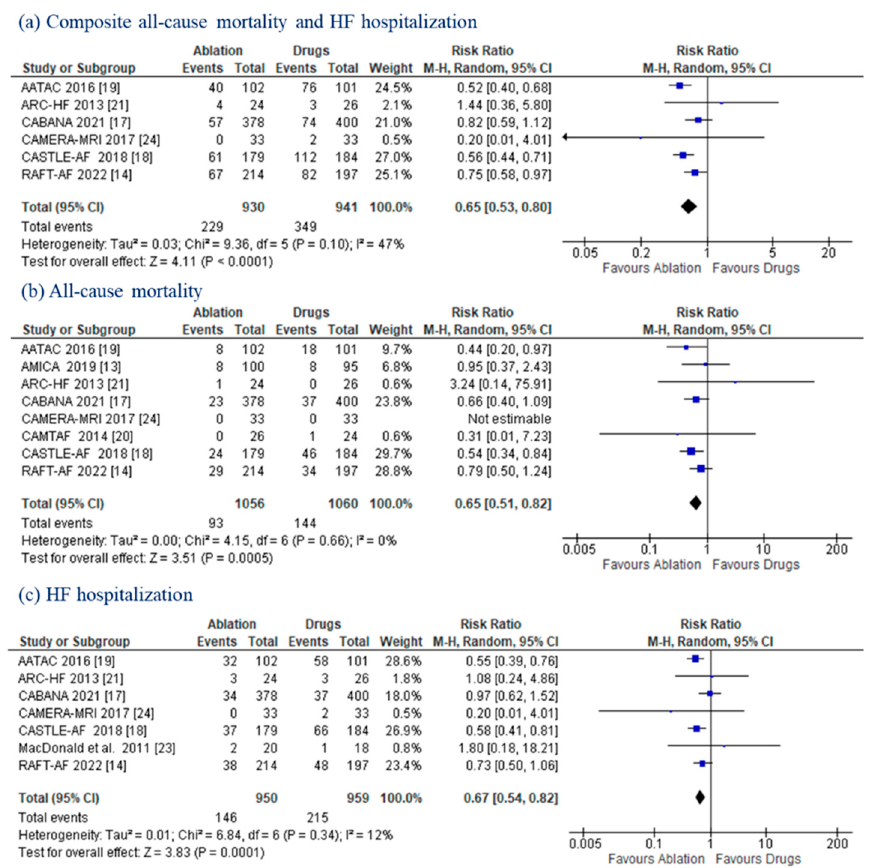
Figure 2. Composite Endpoint, All-Cause Mortality, HF Hospitalizations. Forest plots displaying a decrease in the composite endpoint ( a ), all-cause mortality ( b ), and HF hospitalizations ( c ) in patients with AF and HF undergoing CA versus MT. CI: confidence interval; HF: heart failure.